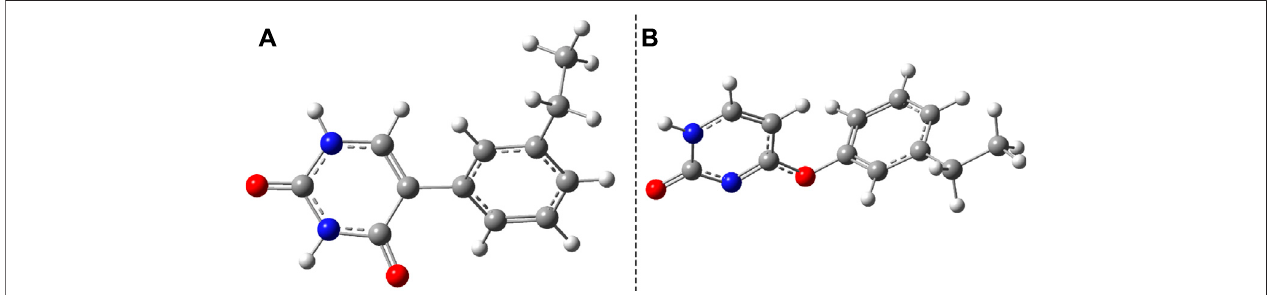
FIGURE 8 | Two possible photoproduct geometries with direct covalent bond for the benzene – uracil (B – U) binary complex: (A) C – C bridge and (B) O – H bridge.